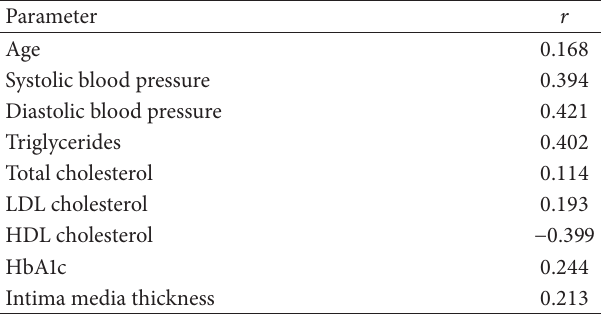
Table 2: Correlation between BMI and cardiometabolic risk